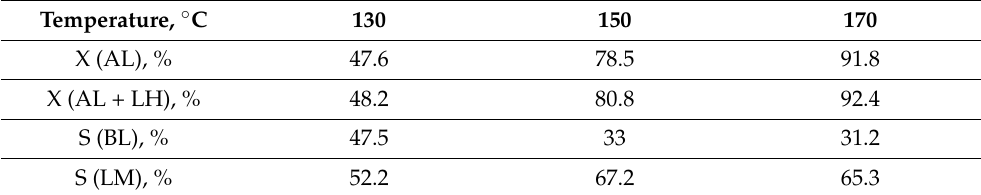
Table 1. Effect of temperature on conversion and selectivity *.